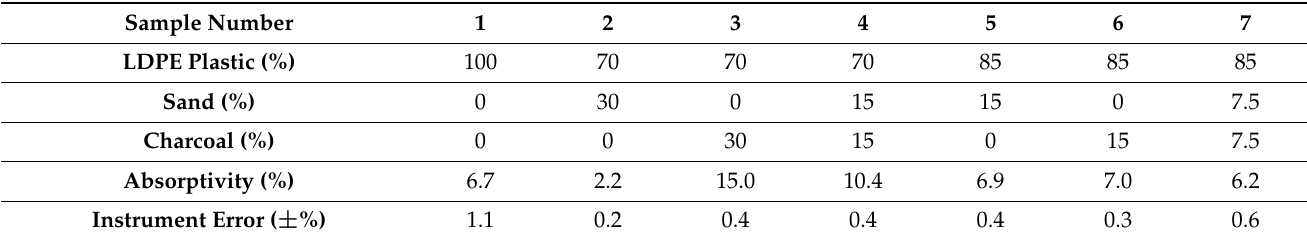
Table 2. Absorptivity (%) obtained for different mixtures using absorptivity test.